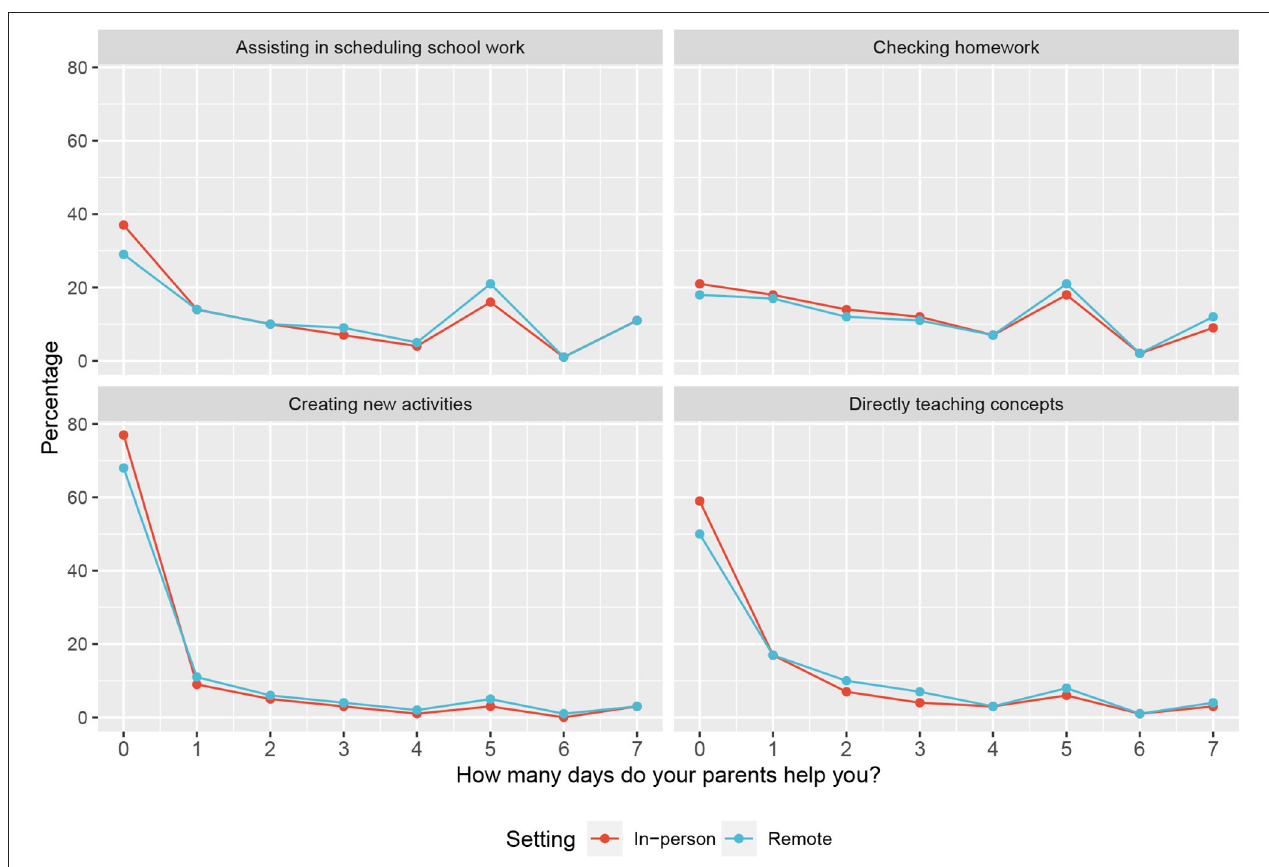
FIGURE 3 | Response distribution (in percent) regarding parental involvement (assisting in scheduling school work, checking homework, creating new activities, and directly teaching concepts), as a function of school setting (in-person or